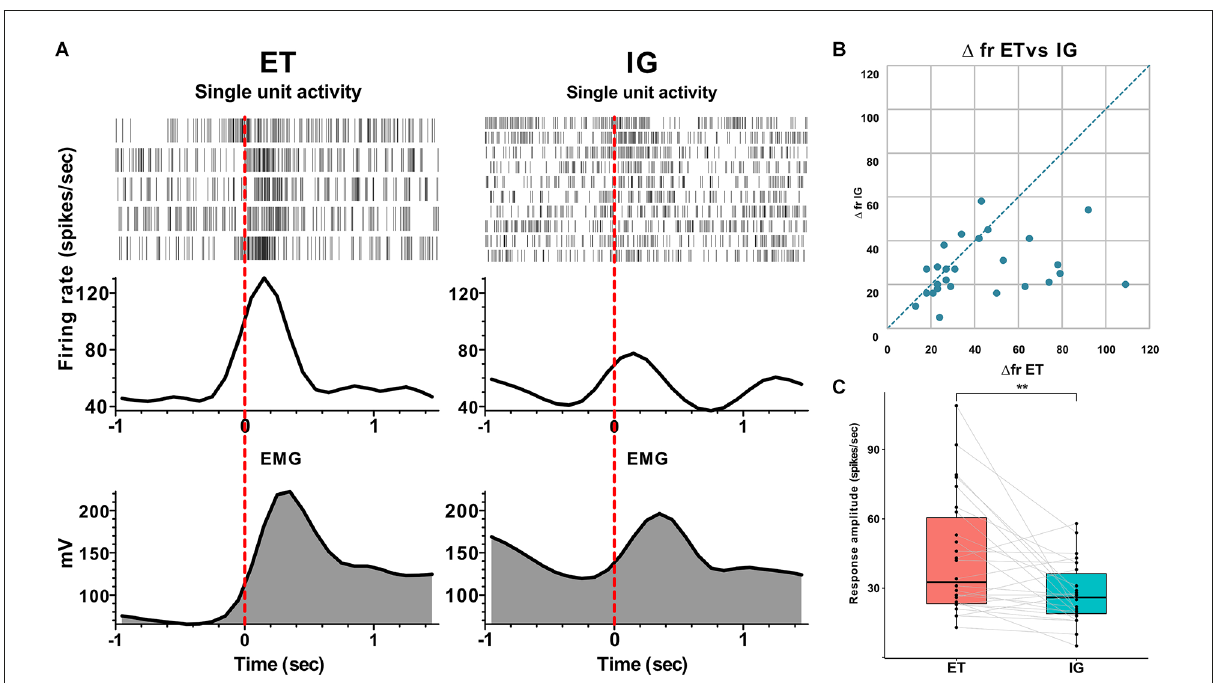
FIGURE1 Neuronal responses of STN units to voluntary ET and IG movements in PD. (A) Examples of perievent raster plots, perievent spike histograms and perievent rectified EMGs for ET and IG movements. (B) Scatter plot of response amplitude (delta firing rate) to ET (x-axis) and IG (y-axis) movements. Each point marks data from one cell. (C) Boxplots with lines of cells responses to ET and IG movements. Abbreviations: STN, subthalamic nucleus; ET, externally triggered; IG, internally guided; PD, Parkinson’s disease. ** p <